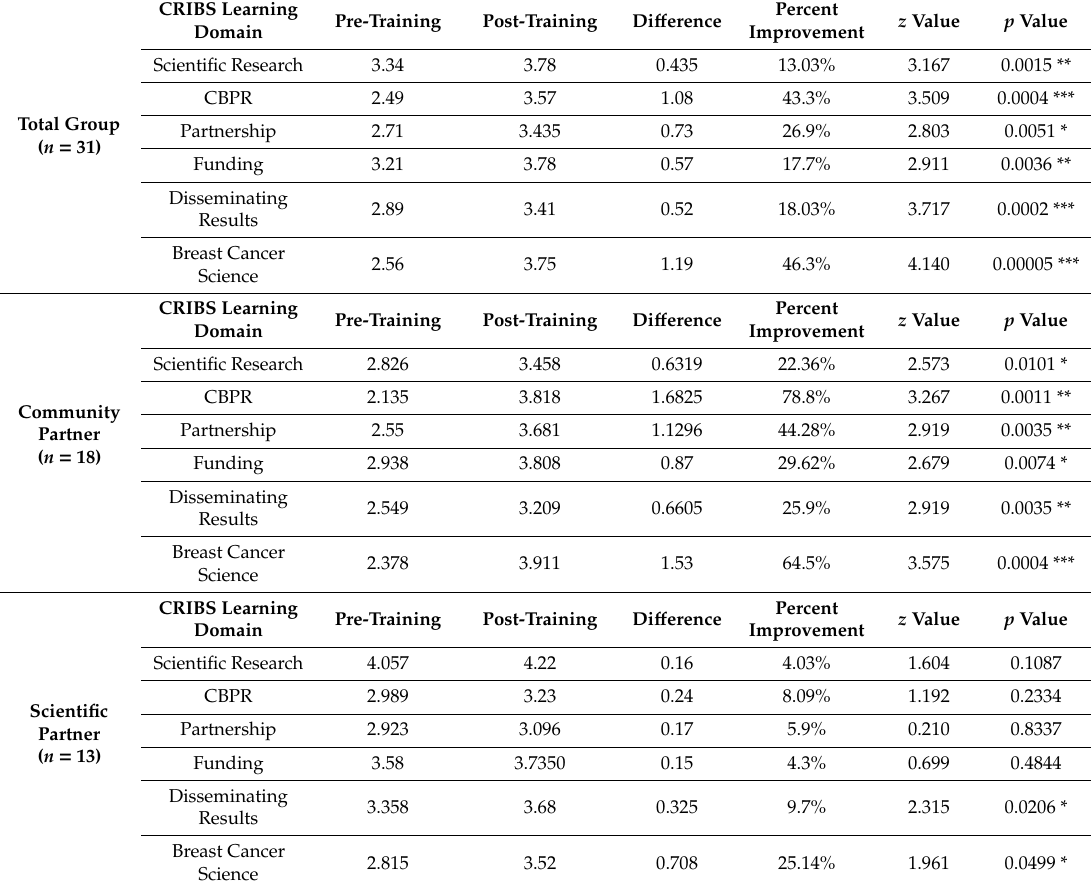
Table 3. CRIBS pre- and post-training self-rated competencies ( n =